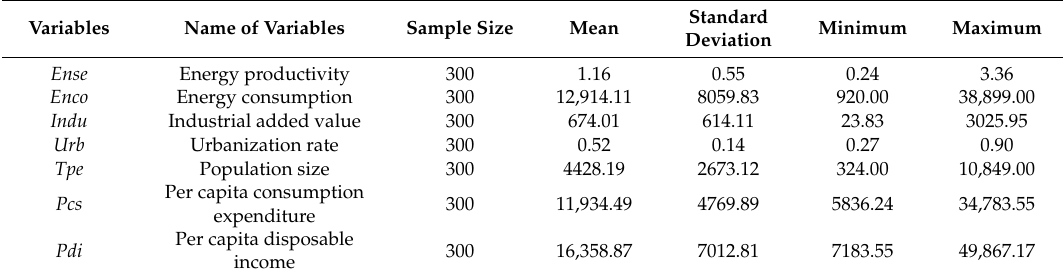
Table 1. Specifications of variables and descriptive